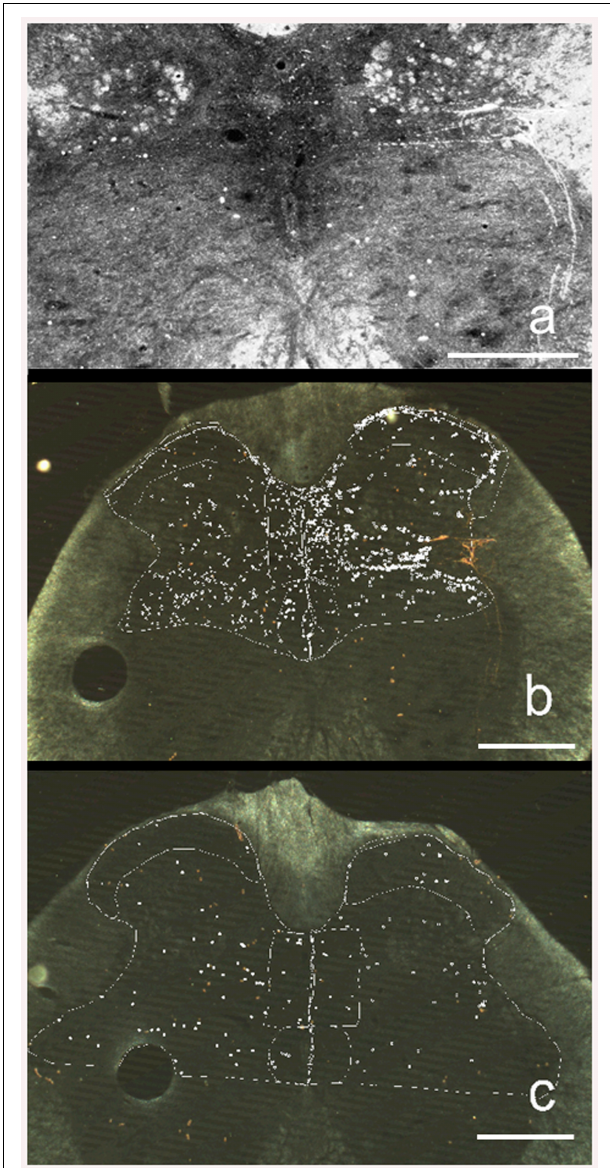
FIGURE 3 | Darkfield illumination photomicrograph (Neurolucida) of transverse 30- μ m sections of the sacral 1 (S1) segment of the spinal cord. The right side of the figures is the left side of the spinal cord. (a) HRP labeling in a rat that received daily repeatedVCS. Brightened image to emphasize appearance and location of HRP particles (white dots). (b) Same section as above showing how HRP counting was made.The white marker dots indicate the locations of HRP particles. Different types of marker dots were used to differentiate the selected regions of the spinal cord. (c) HRP labeling in a control rat that did not receive daily repeatedVCS. Calibration bar = 200 μ .